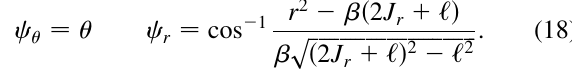
for linear system, U (cid:5) 0 . r